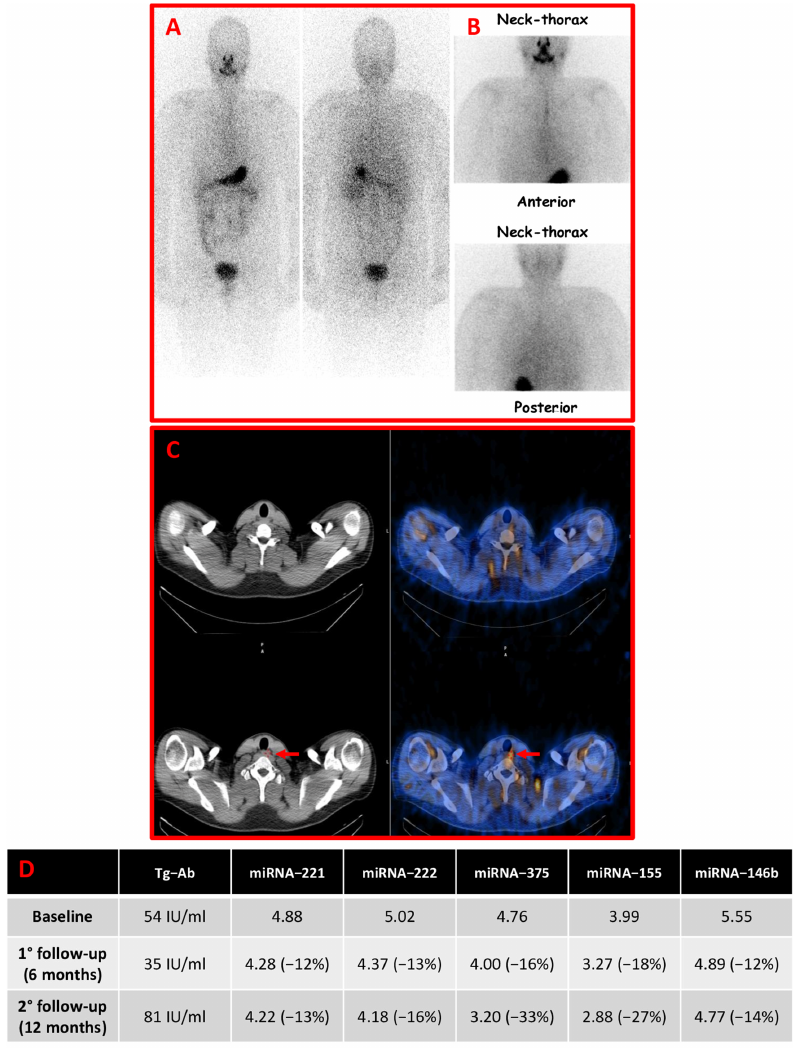
Figure 1. A male PTC patient, aged 54 years, with a multifocal and bilateral PTC [pT1b(m), Nx, Mx], and incomplete structural response (SIR) after initial treatments (surgery + RIT). Imaging findings and serum miRNAs changes are reported. Panel ( A , B ) 123 I-Dx-WBS (222 MBq; anterior and posterior views) and planar imaging of the neck-thoracic region (anterior and posterior views). No abnormal radioiodine uptake was noted. Panel ( C ) SPECT/CT imaging (axial images) showed an abnormal radioiodine uptake involving at least a small-sized lymph node of the VI Robbins’ level (red arrows). ( D ) Changes in TgAb and circulating miRNAs 221, 222, and 146b levels during the follow-up in the